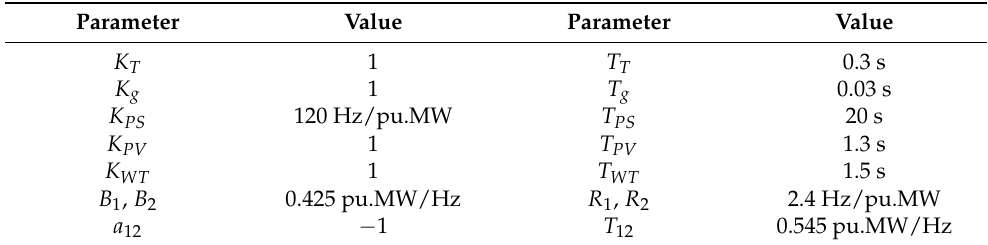
Table 1. System Table 1. System parameters.